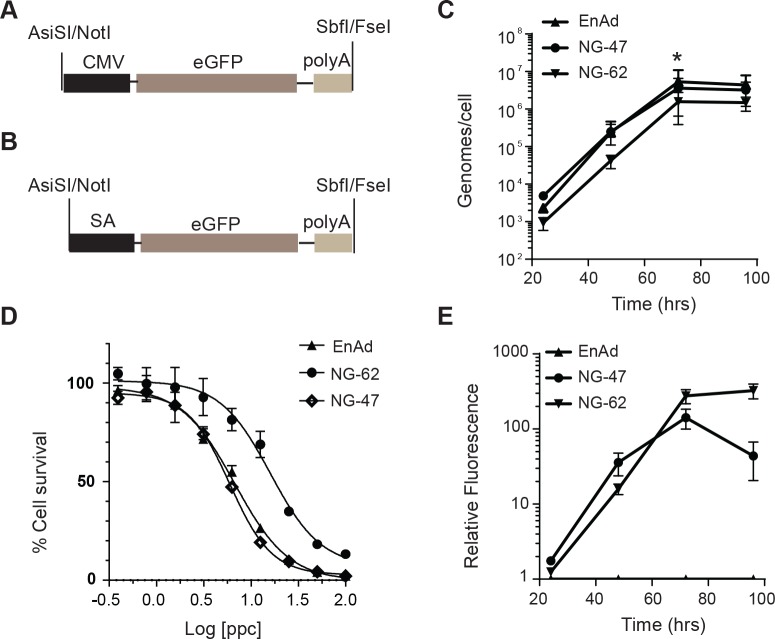
Reporter transgene expression mediated by endogenous and exogenous promoters.(A) Schematic of the GFP expression cassette encoded in the NG-47 and NG-274 viruses. (B) Schematic of the GFP expression cassette encoded in the NG-62 and NG-252 virus. (C) The total genomes generated per HT-29 colon carcinoma cell infected for 24–96 hrs with 1 particle per cell (ppc) NG-47, NG-62 or enadenotucirev (EnAd) virus particles. Graph shows mean ± SD (n = 3 independent experiments, *P<0.05). (D) HT-29 cells infected with enadenotucirev, NG-47 or NG-62 virus particles over a range of 100–0.39 ppc for 72hrs then assessed for cell viability by MTS assay. Graph shows quantification of % cell survival, defined by mitochondrial activity, relative to uninfected controls. (E) Quantification of total accumulated GFP fluorescence in wells containing HT-29 cells infected, as in (C), for 24-96hrs with 1ppc of enadenotucriev, NG-47 or NG-62 virus particles. Graph shows the fold change in fluorescence at each time point relative to uninfected control cells plotted as mean ± SD (n = 3 independent experiments), no signal could be detected at any time point in enadenotucirev infected cells.